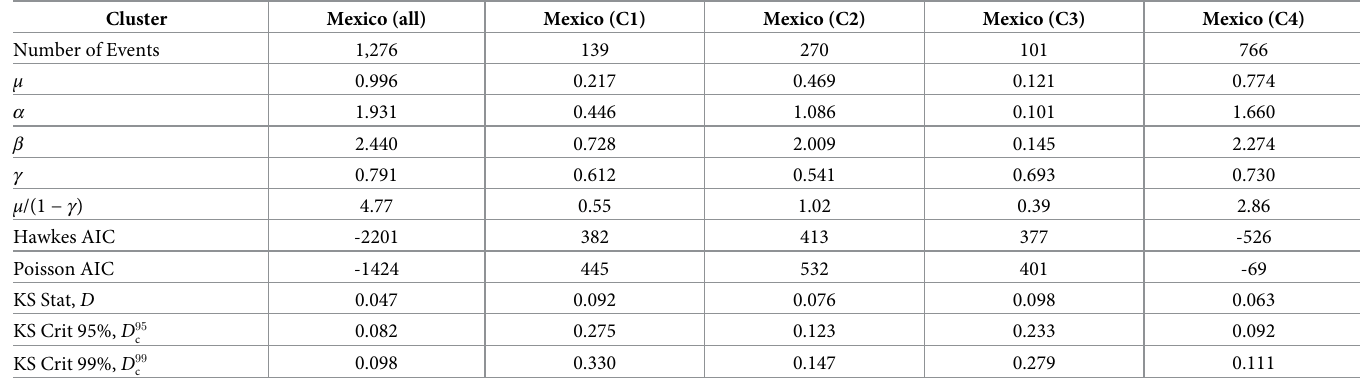
Table 4. Statistical outcomes of the Hawkes process applied to data from Mexico. The Hawkes process outperforms the baseline Poisson process both nationwide and in each cluster, since the Hawkes AIC is always less than the Poisson AIC. The Hawkes process passes the KS test at the 95% significance level in all cases, with D < D 95